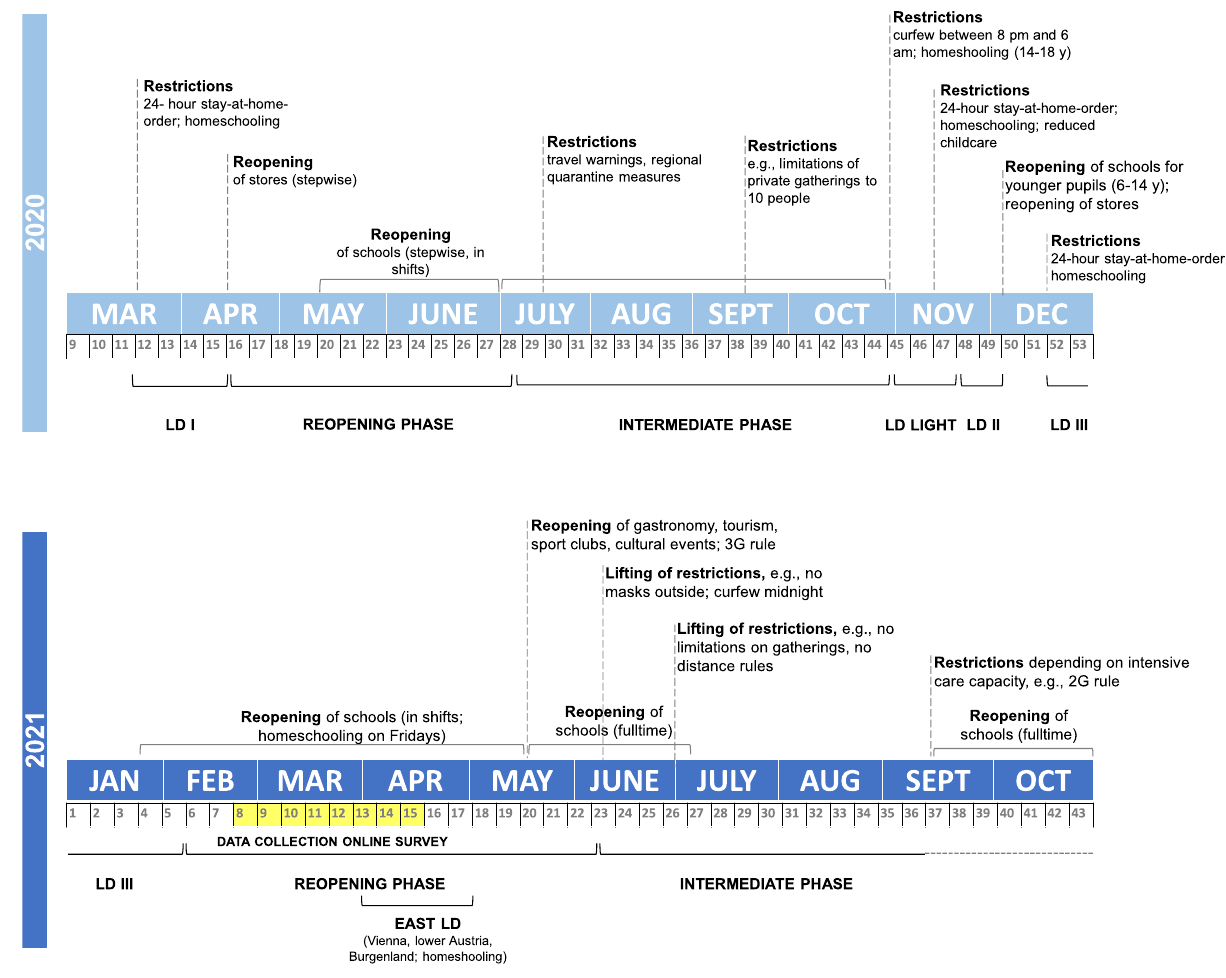
Figure 8. Timeline of COVID-19 related measures in Austria from March 2020 to September 2021 including information about lockdowns (LD) and school closures/reopenings. Highlighted in yellow is the time window of data collection for the online